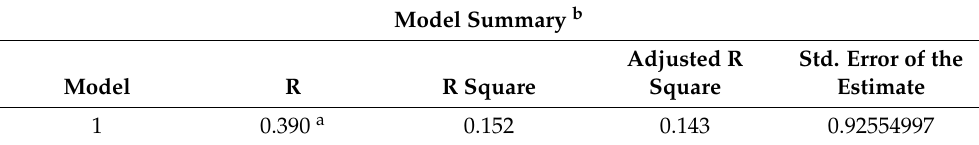
Table 9. Regression model